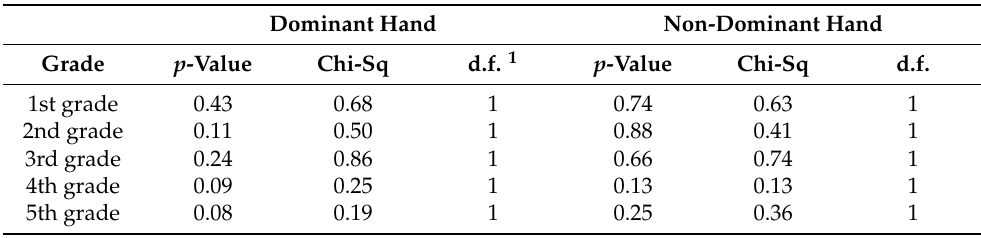
Table 17. Friedman’s test between BBT scores at the baseline and BBT scores post gross motor skills